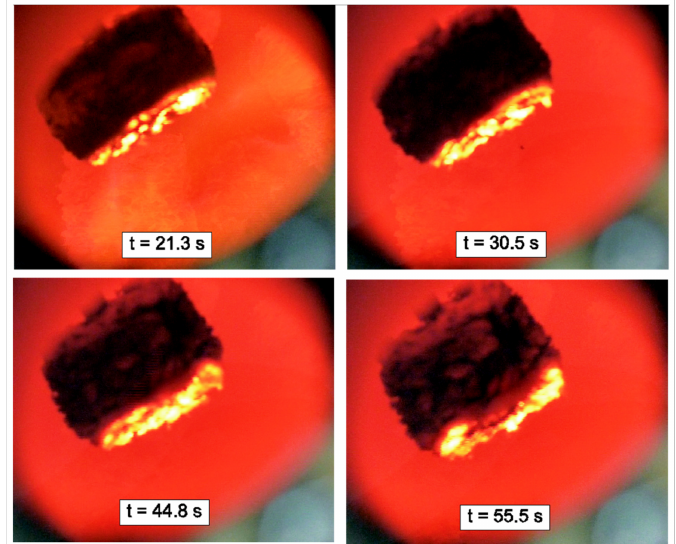
Figure 3. Solid residue combustion and swelling.